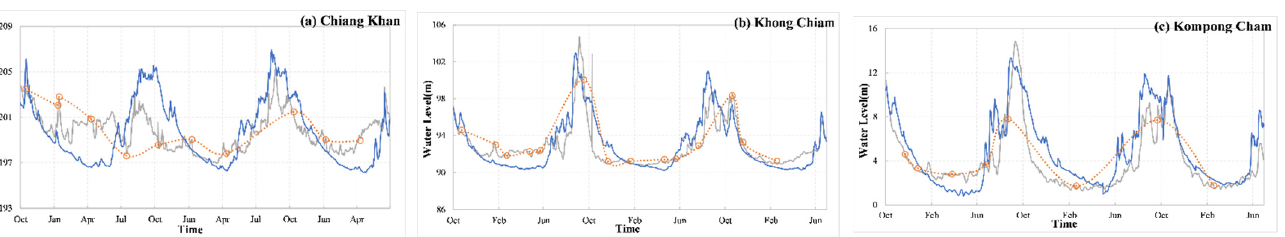
Figure 5. Timeseries of water level data in the Mekong River at different hydrological stations. (( a ) Chiang Khan, ( b ) Khong Chiam, ( c ) Kompong Cham).